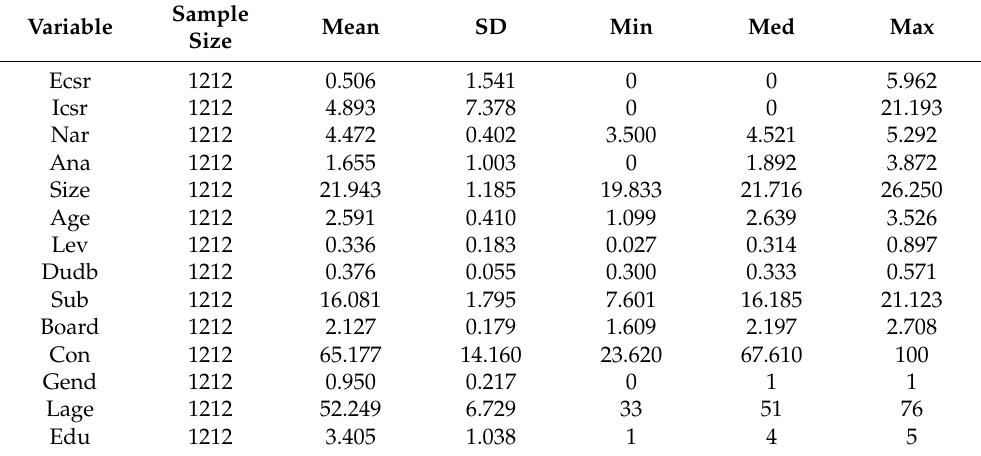
Table 2. Main descriptive statistics.